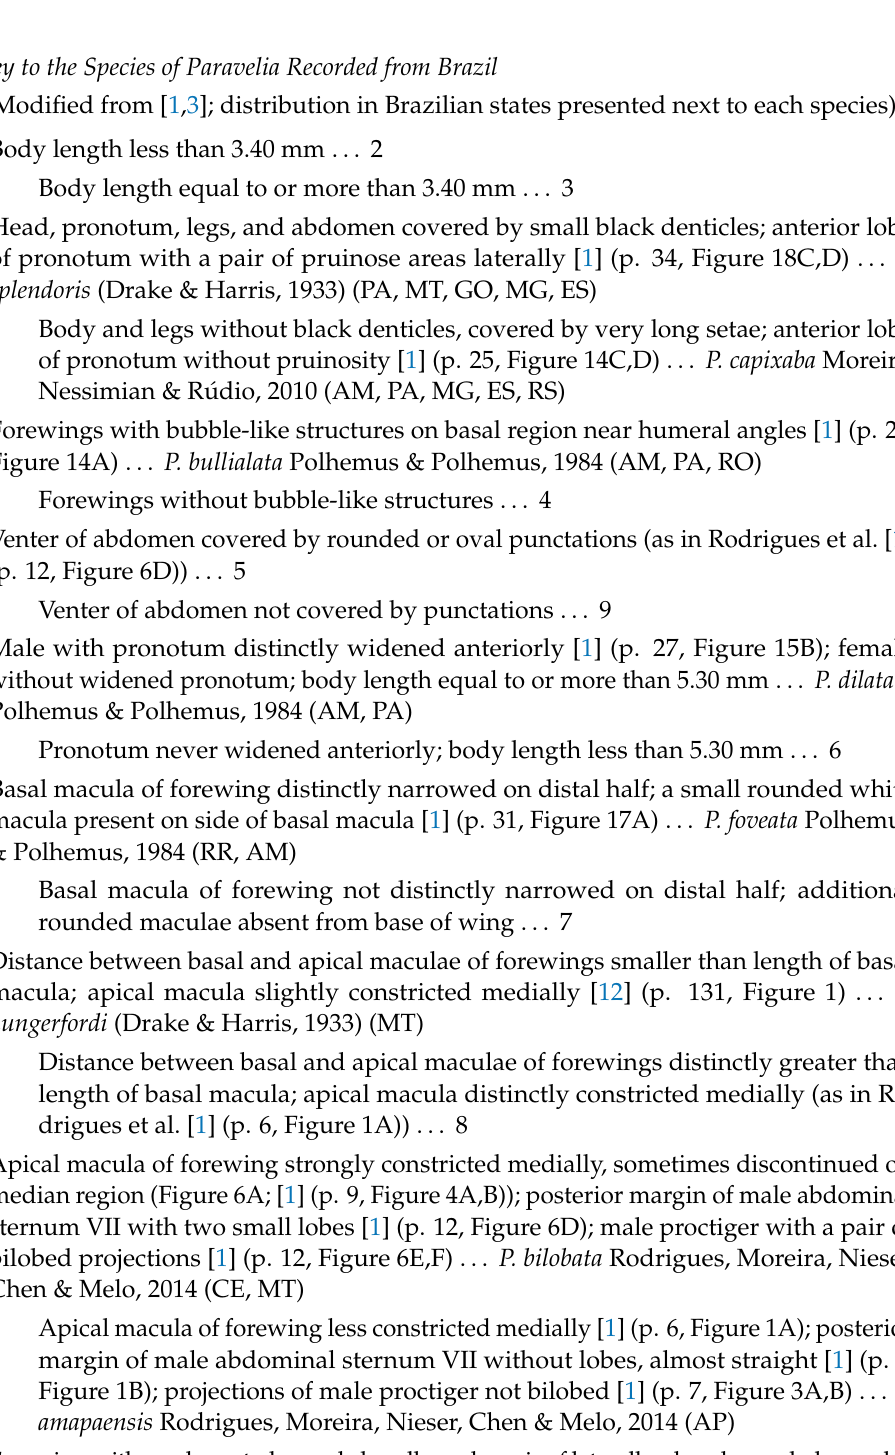
3.3. Key to the Species of Paravelia Recorded from Brazil (Modified from [1,3]; distribution in Brazilian states presented next to each species) 1. Body length less than 3.40 mm . . . 2 - Body length equal to or more than 3.40 mm . . . 3 2. Head, pronotum, legs, and abdomen covered by small black denticles; anterior lobe of pronotum with a pair of pruinose areas laterally [1] (p. 34, Figure 18C,D) . . . P. splendoris (Drake & Harris, 1933) (PA, MT, GO, MG, ES) - Body and legs without black denticles, covered by very long setae; anterior lobe of pronotum without pruinosity [1] (p. 25, Figure 14C,D) . . . P. capixaba Moreira, Nessimian & R ú dio, 2010 (AM, PA, MG, ES, RS) 3. Forewings with bubble-like structures on basal region near humeral angles [1] (p. 25, Figure 14A) . . . P. bullialata Polhemus & Polhemus, 1984 (AM, PA, RO) - Forewings without bubble-like structures . . . 4 4. Venter of abdomen covered by rounded or oval punctations (as in Rodrigues et al. [1] (p. 12, Figure 6D)) . . . 5 - Venter of abdomen not covered by punctations . . . 9 5. Male with pronotum distinctly widened anteriorly [1] (p. 27, Figure 15B); female without widened pronotum; body length equal to or more than 5.30 mm . . . P. dilatata Polhemus & Polhemus, 1984 (AM, PA) - Pronotum never widened anteriorly; body length less than 5.30 mm . . . 6 6. Basal macula of forewing distinctly narrowed on distal half; a small rounded white macula present on side of basal macula [1] (p. 31, Figure 17A) . . . P. foveata Polhemus & Polhemus, 1984 (RR, AM) - Basal macula of forewing not distinctly narrowed on distal half; additional rounded maculae absent from base of wing . . . 7 7. Distance between basal and apical maculae of forewings smaller than length of basal macula; apical macula slightly constricted medially [12] (p. 131, Figure 1) . . . P. hungerfordi (Drake & Harris, 1933) (MT) - Distance between basal and apical maculae of forewings distinctly greater than length of basal macula; apical macula distinctly constricted medially (as in Ro- drigues et al. [1] (p. 6, Figure 1A)) . . . 8 8. Apical macula of forewing strongly constricted medially, sometimes discontinued on median region (Figure 6A; [1] (p. 9, Figure 4A,B)); posterior margin of male abdominal sternum VII with two small lobes [1] (p. 12, Figure 6D); male proctiger with a pair of bilobed projections [1] (p. 12, Figure 6E,F) . . . P. bilobata Rodrigues, Moreira, Nieser, Chen & Melo, 2014 (CE, MT) - Apical macula of forewing less constricted medially [1] (p. 6, Figure 1A); posterior margin of male abdominal sternum VII without lobes, almost straight [1] (p. 6, Figure 1B); projections of male proctiger not bilobed [1] (p. 7, Figure 3A,B) . . . P. amapaensis Rodrigues, Moreira, Nieser, Chen & Melo, 2014 (AP) 9. Forewing with an elongated macula basally and a pair of laterally placed rounded maculae apically; all maculae whitish (as in Rodrigues et al. [1] (p. 15, Figure 14B)) . . . 10 - Forewing maculae not as above . . . 11 10. Body length 3.60–4.20 mm; legs brown, lighter towards base, unarmed; forewing with basal macula long, starting close to humeral angle of pronotum . . . P. capillata (Drake & Harris, 1933) (SE, MT) - Body length 4.55–4.95 mm; legs annulate, with black spinules on femora and tibiae; forewing with basal macula short, starting after apex of pronotum . . . P. cognata (Drake & Harris, 1933) (MA,